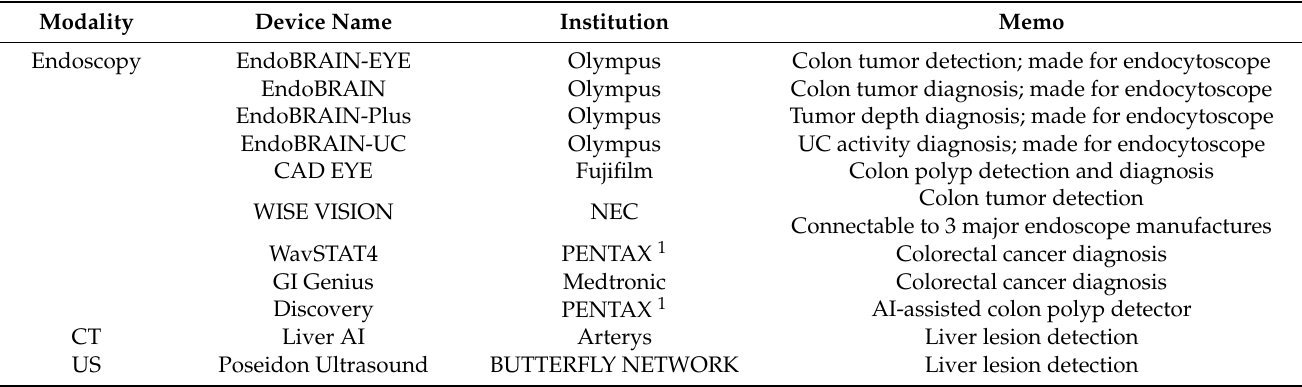
Figure 2. Schematics of neural networks and number of publications of medical AI. ( A ) A schematic of a traditional neural network algorithm. ( B ) A schematic of a neural network with deep learning algorithm. ( C ) The number of publications involving AI in the medical field. The results of a PubMed search using the following key words (“artificial intelligence” OR “machine learning” OR “deep learning” OR “neural network”) AND (medicine OR gastroenterology OR hepatology OR pancreatology OR endoscopy OR radiology OR ultrasonography OR “computed tomography” OR “clinical imaging“) are shown. Table 1. AI-aided devices approved in the fields of gastroenterology.